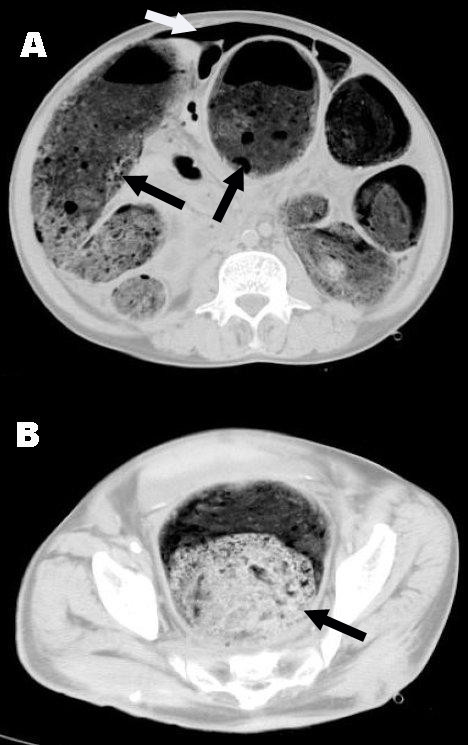
(A) Computed tomography (CT) of abdomen showed extra-luminal free air in the peritoneal cavity (white arrow), and marked distension of colonic loop with fecal impaction (black arrow). (B) Fecal impaction with marked colon distention was noted in the distal sigmoid colon (black arrow).